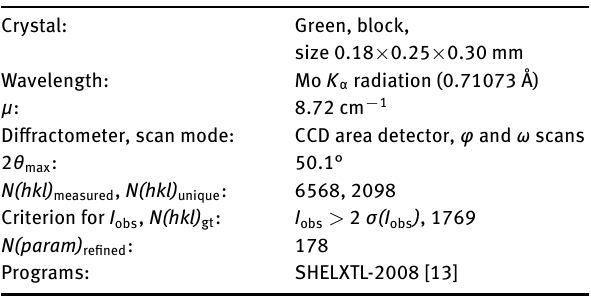
Table 1: Data collection and handling.